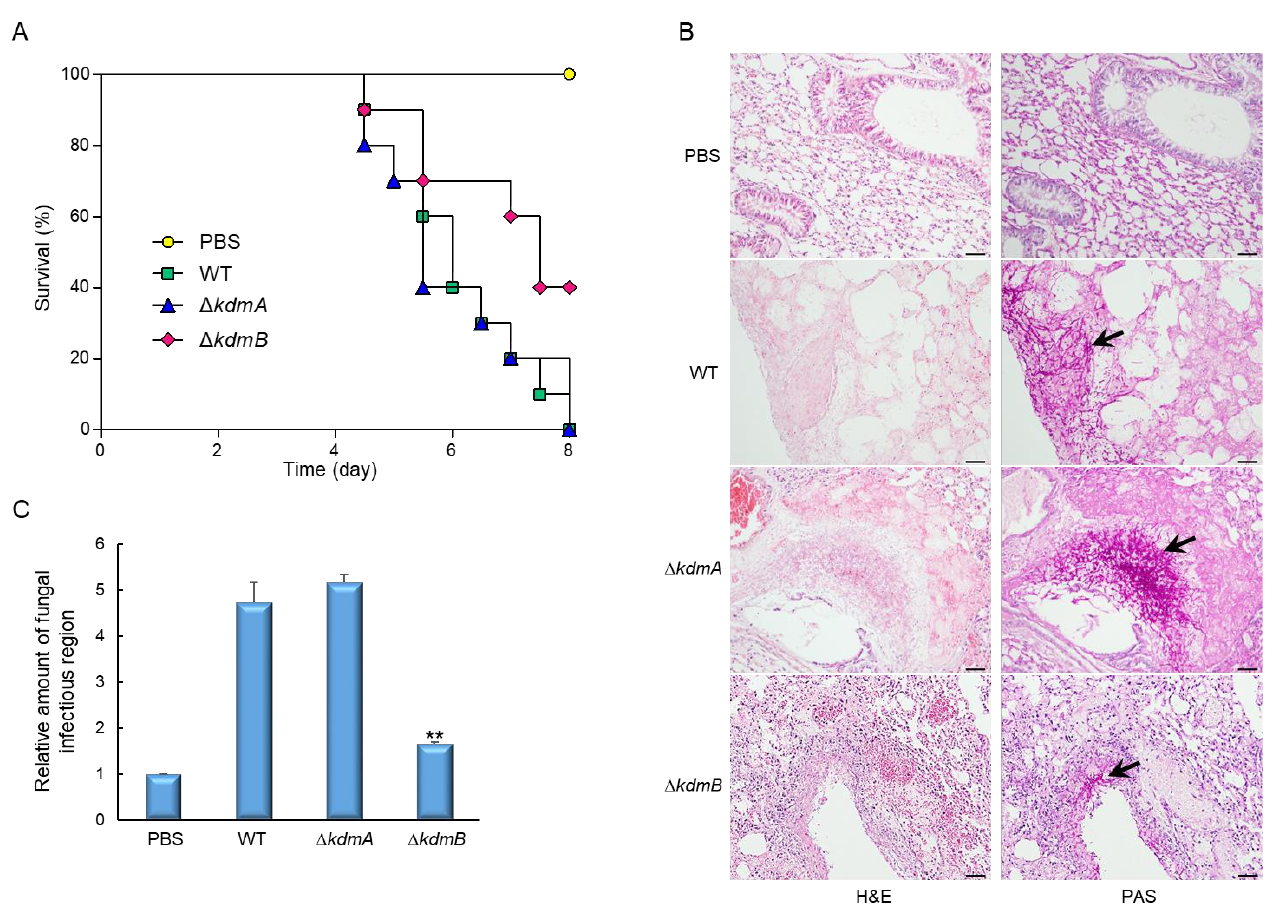
Figure 6. Effects of KdmA and KdmB on A . fumigatus virulence. ( A ) Survival curves of mice intranasally administered with PBS or with conidia of the WT or one of the mutant strains (n = 10/group). ( B ) Representative lung sections of mice from different experimental groups stained with hematoxylin and eosin (H&E) or periodic acid – Schiff reagent (PAS). Arrows indicate fungal mycelium. Scale bar = 50 µm. ( C ) Fungal burden in the lungs of mice infected with the WT or one of the mutant strains. Statistical significance of differences between WT and mutant strains was evaluated by Student’s t -test: ** p < 0.01.